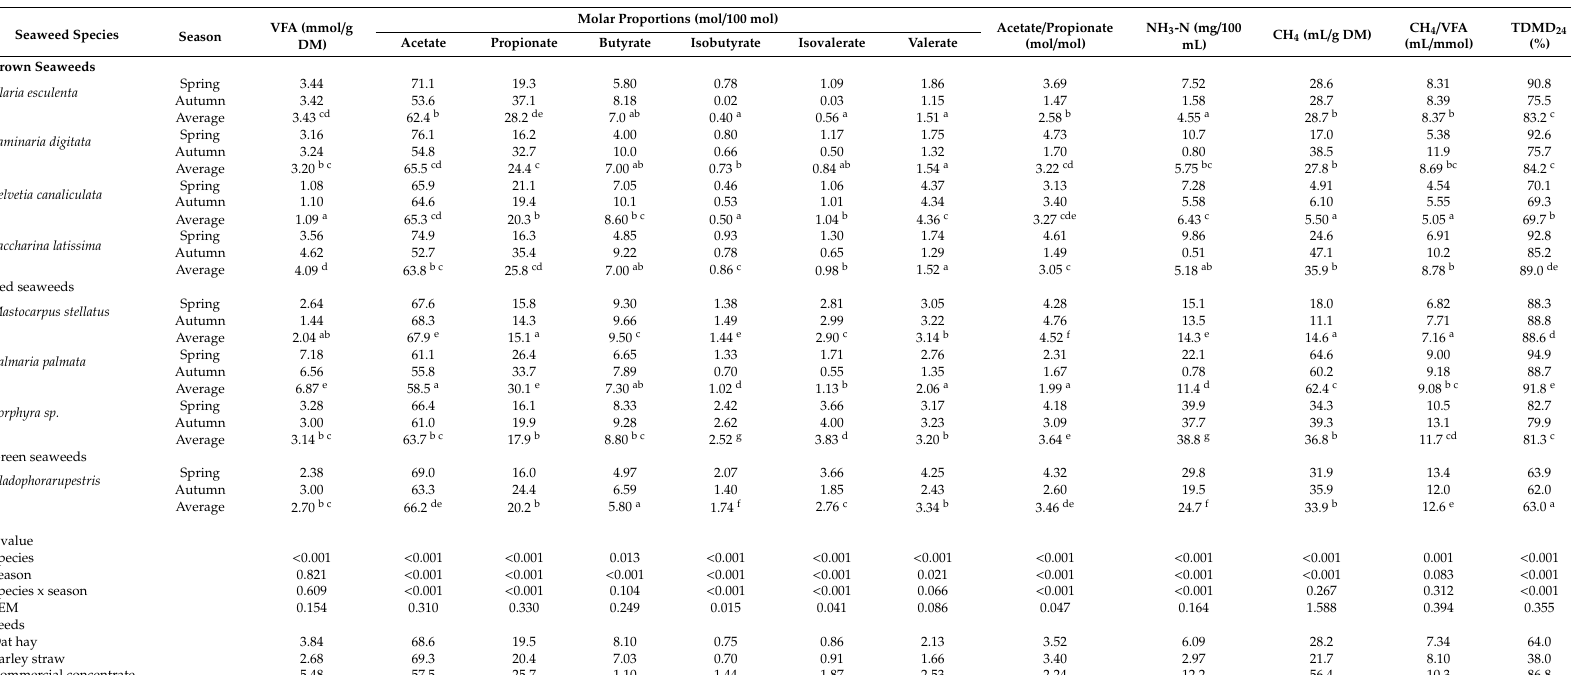
Table 4. Fermentation parameters and true dry matter (DM) digestibility (TDMD 24 ) after 24 h of in vitro incubation of di ff erent seaweed species harvested in spring and autumn in northern Norway and of feeds commonly used in ruminant